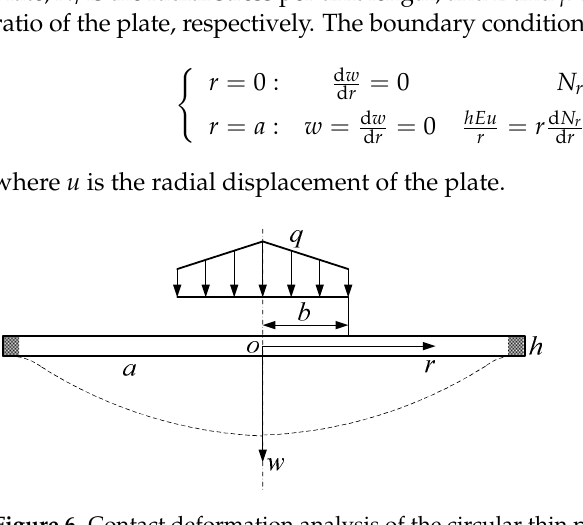
Figure 6. Contact deformation analysis of the circular thin plate.